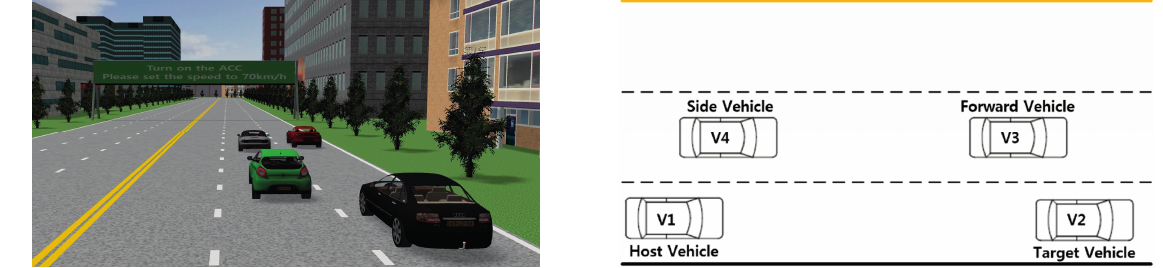
Figure 11. Host and surrounding vehicles in the